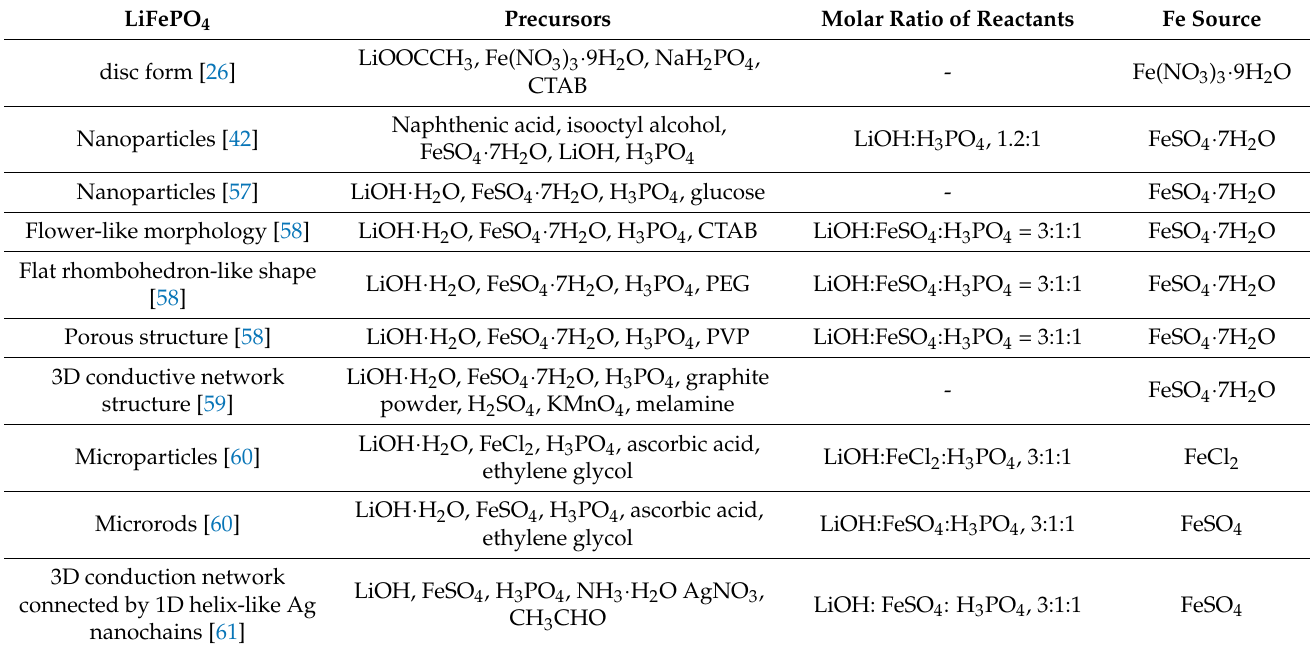
Table 3. Comparison of synthetic processes during hydrothermal